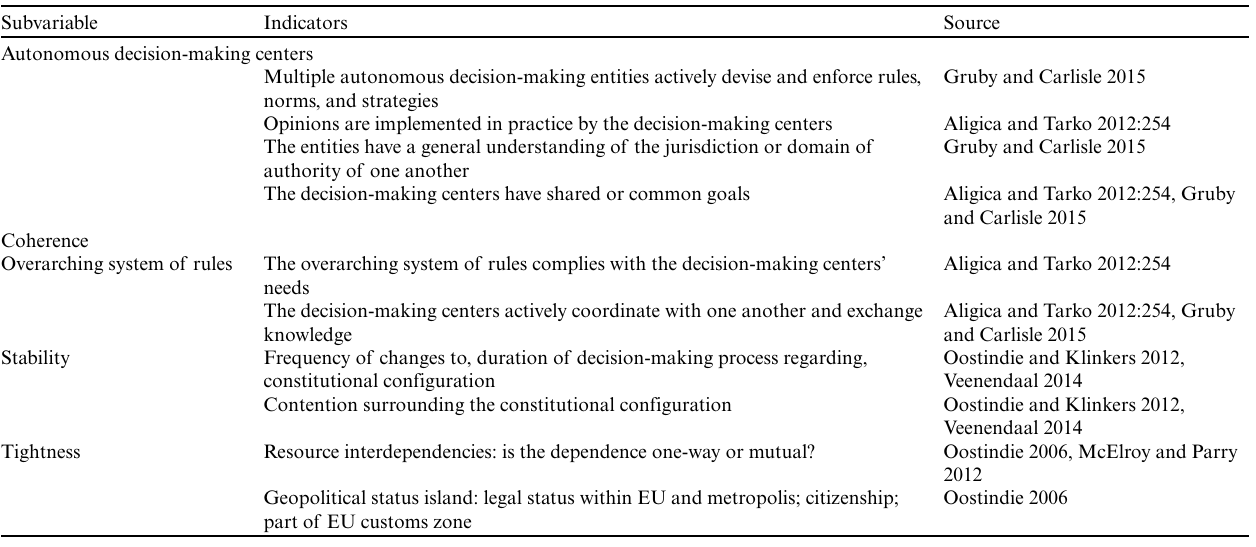
Table 1. Overview of the subvariables and their indicators of the polycentric governance configurations